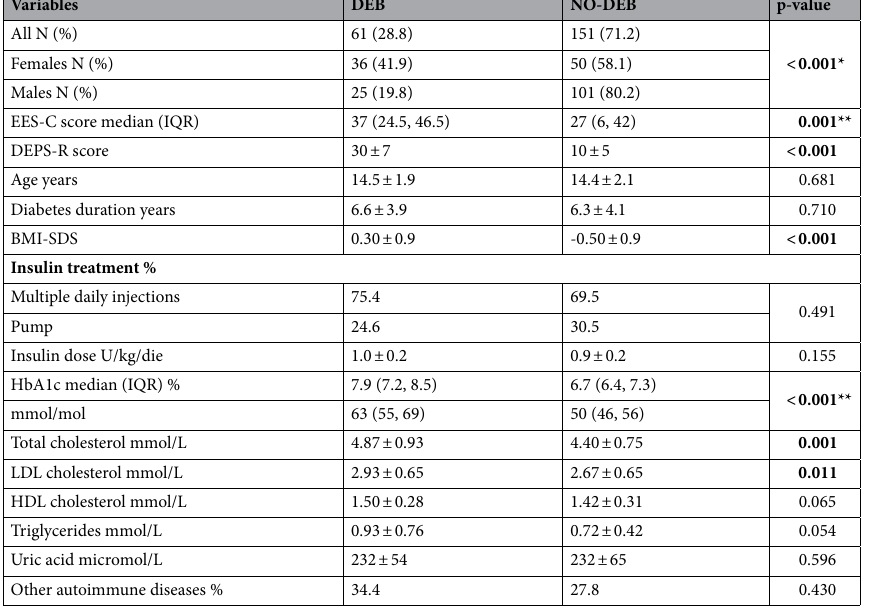
Table 3. Characteristics of patients with and without disordered eating behaviors (DEB). Data are presented as mean and standard deviation unless otherwise specified. For comparisons between groups two-tailed t-test was used. IQR inter quartile range, DEPS-R diabetes eating problem survey-revised, EES-C emotional eating scale for children and adolescents, DEB subjects with disordered eating behaviors (DEPS-R score ≥ 20), NO-DEB subjects without disordered eating behaviors (DEPS-R score < 20), BMI-SDS body mass index- standard deviation score, HbA1c glycated hemoglobin, LDL low density lipoprotein, HDL high density lipoprotein. *Females with DEB vs males with DEB (chi-square test). ** Mann–Whitney test. Significant values are in bold.